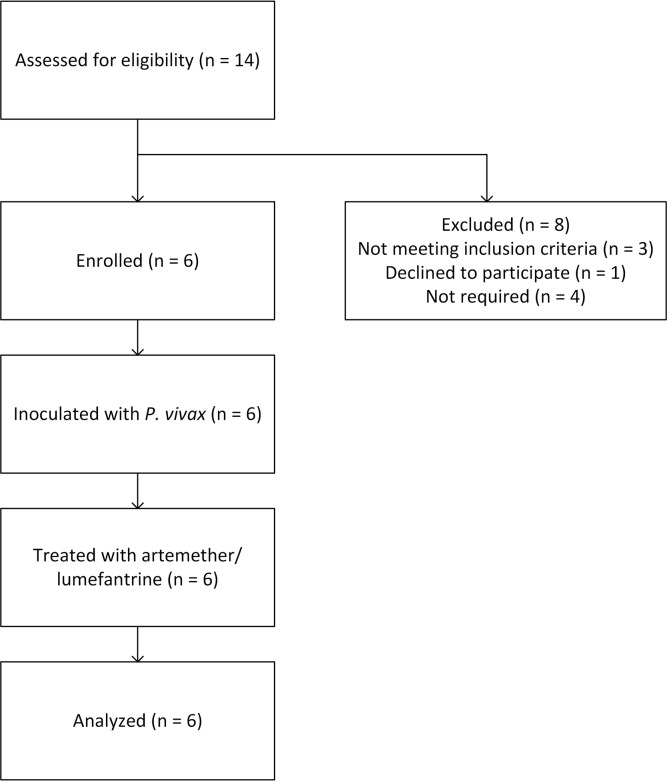
Study flow diagram.